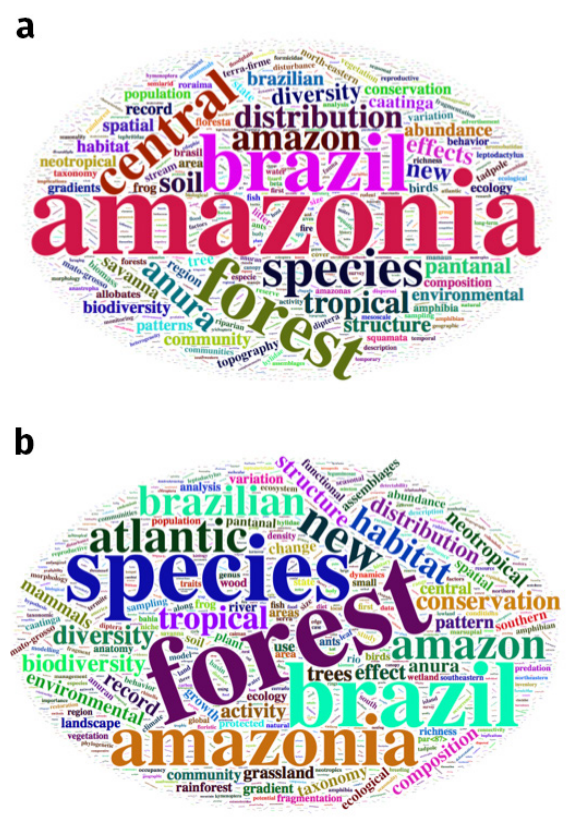
Figure 2. Word cloud using the words presented in the 1179 scientific papers titles and key-words. a) papers published to the end of 2012 and b) papers published after 2012. In both, the size of the word is proportional to its citation